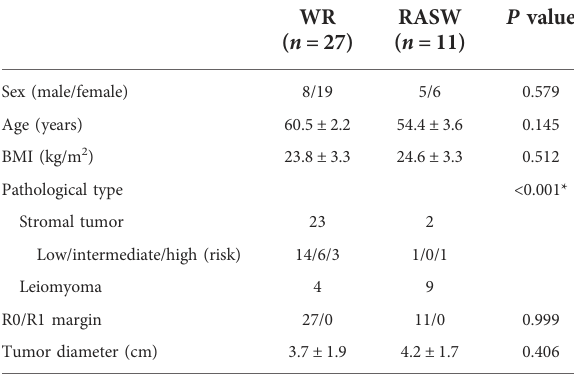
TABLE 1 The baseline characteristics and pathology of the